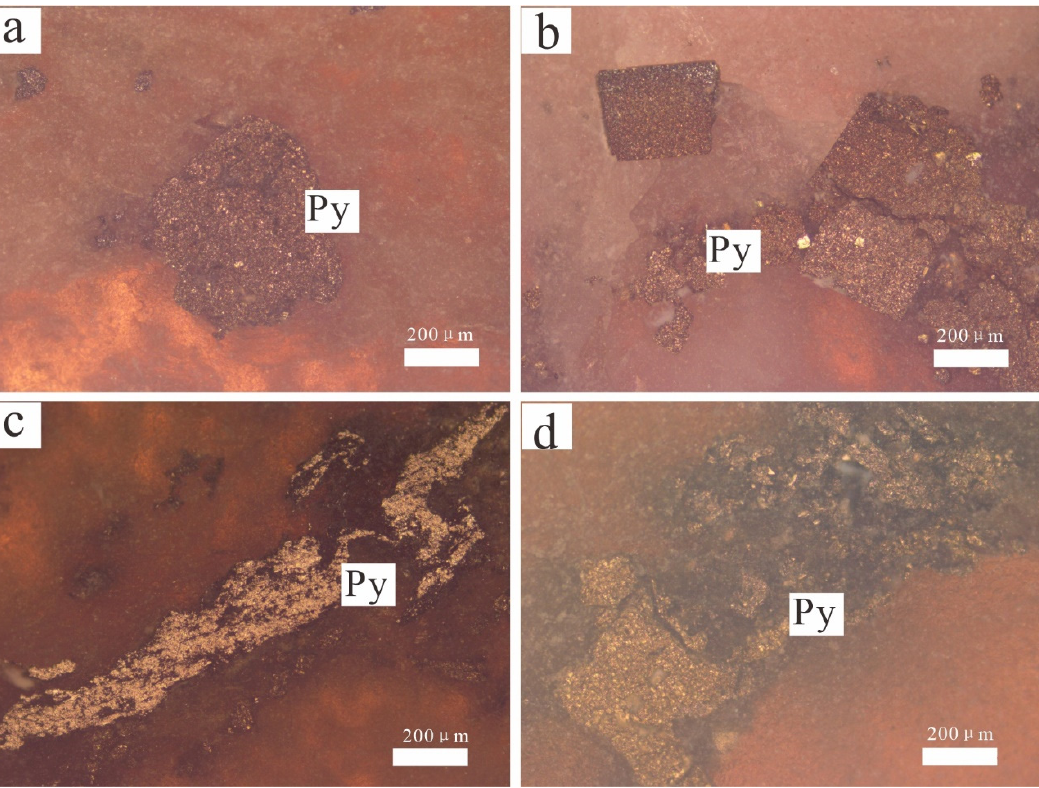
Figure 7. Copper coatings used for the pyrite thermoelectric tests. ( a , b ): euhedral pyrite; ( c , d ): subhedral to anhedral pyrite. Py = pyrite.